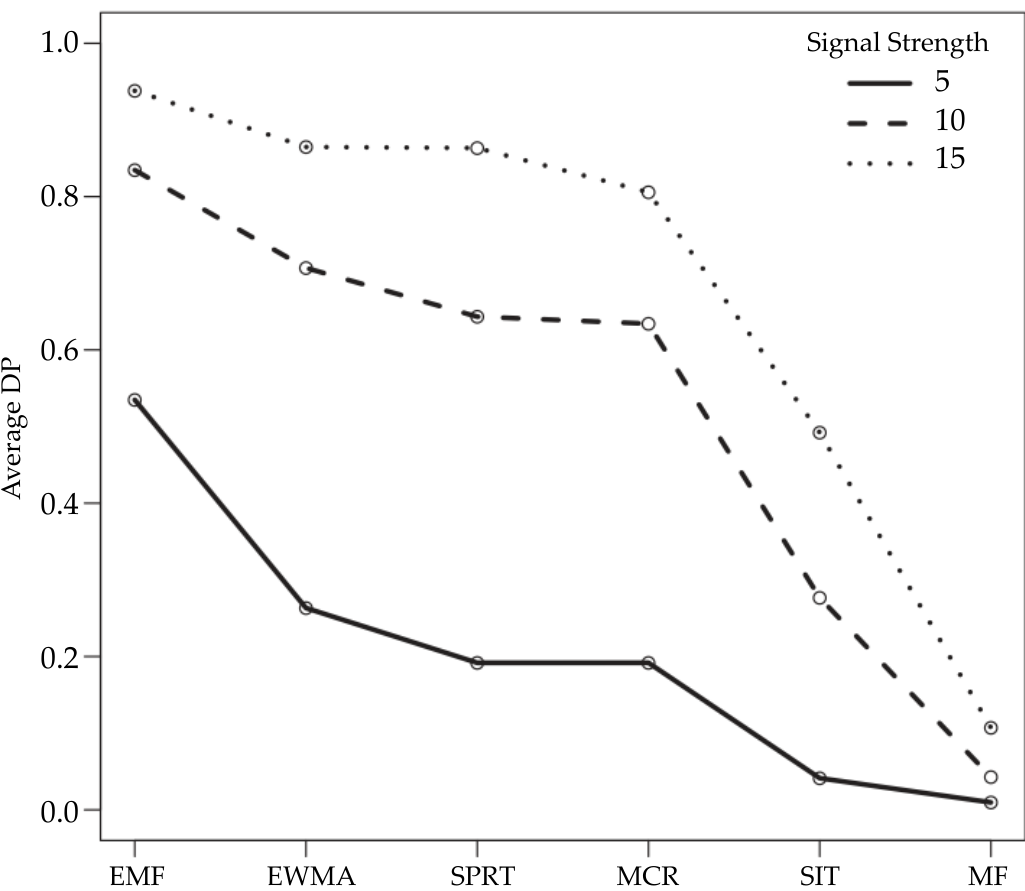
Figure 6. Comparison of the data processing methods estimated matched filtering (EMF), exponentially weighted moving average (EWMA), sequential probability ratio test (SPRT), maximum count rate (MCR), single-interval testing (SIT) and matched filter (MF) based on a Poisson model of neutron background and source counts, from [66]. Detection probabilities (DP or TPR) are averaged over twenty-four scenarios evaluated with the FPR set at 0.01. The signal strength refers to the counts of the modeled sources as a multiple of the modeled background counts. Reprinted, with permission, from [66]. © 2013 American Statistical Association, reprinted by permission of Taylor & Francis Ltd, on behalf of American Statistical